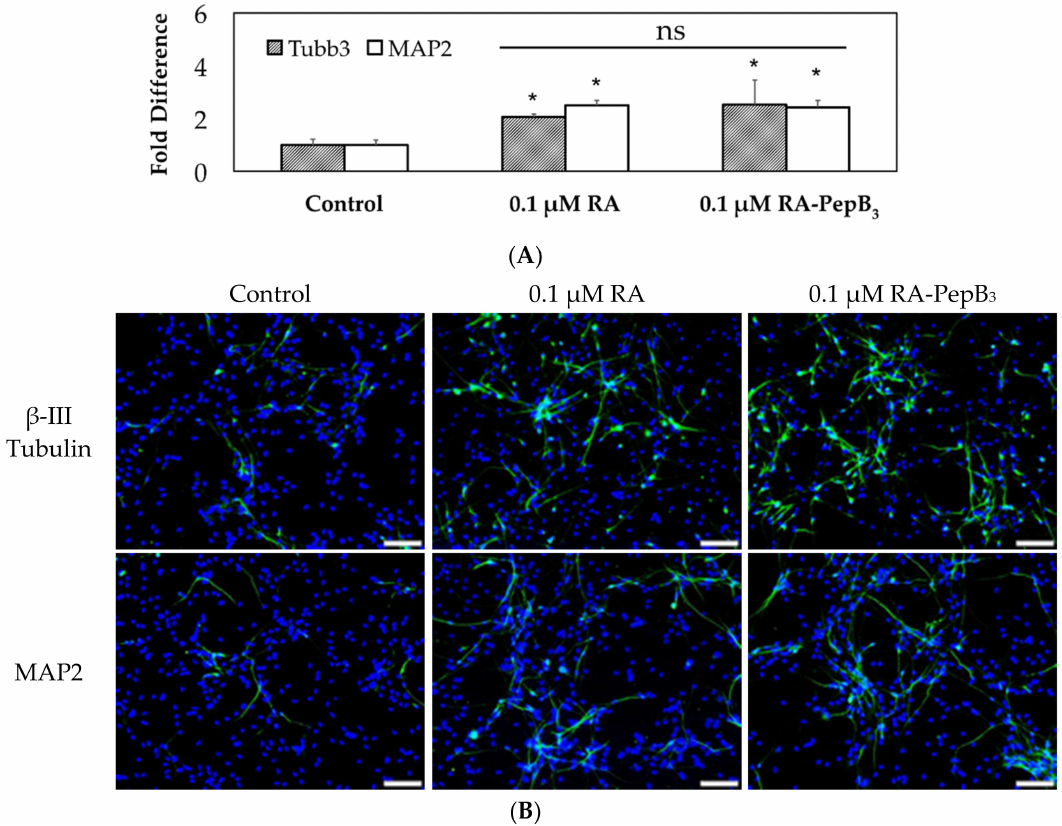
Figure 11. Long-term low-concentration RVM differentiation results. ( A ) Comparison of β -III tubulin and MAP2 expression levels in four-week differentiated RVM. ns: no significant. ( B ) Fluorescence microscopy images of ReNcell VM after four weeks of differentiation. Cells were stained for nuclei (DAPI; blue), β -III tubulin (green, top row), and MAP2 (green, bottom row). Control group cells were differentiated with only growth factor withdrawal (no additional compounds added). N = 3; error bars depicted as SD; * p < 0.05 compared to control expression levels; scale bar = 100 µ